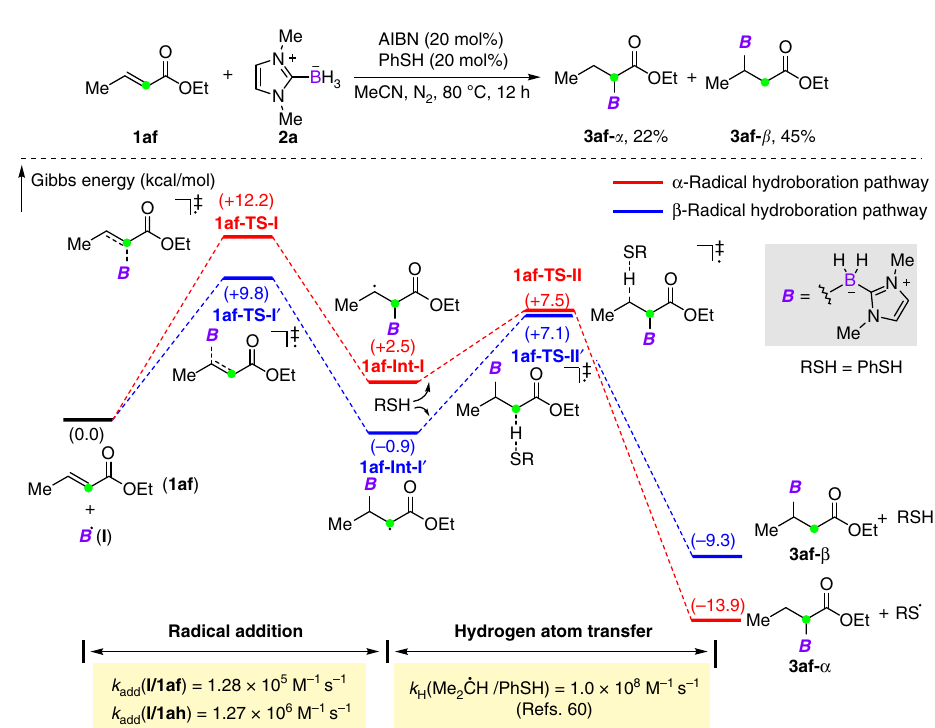
Fig. 6 Theoretical calculations. DFT calculations of radical hydroborylation of